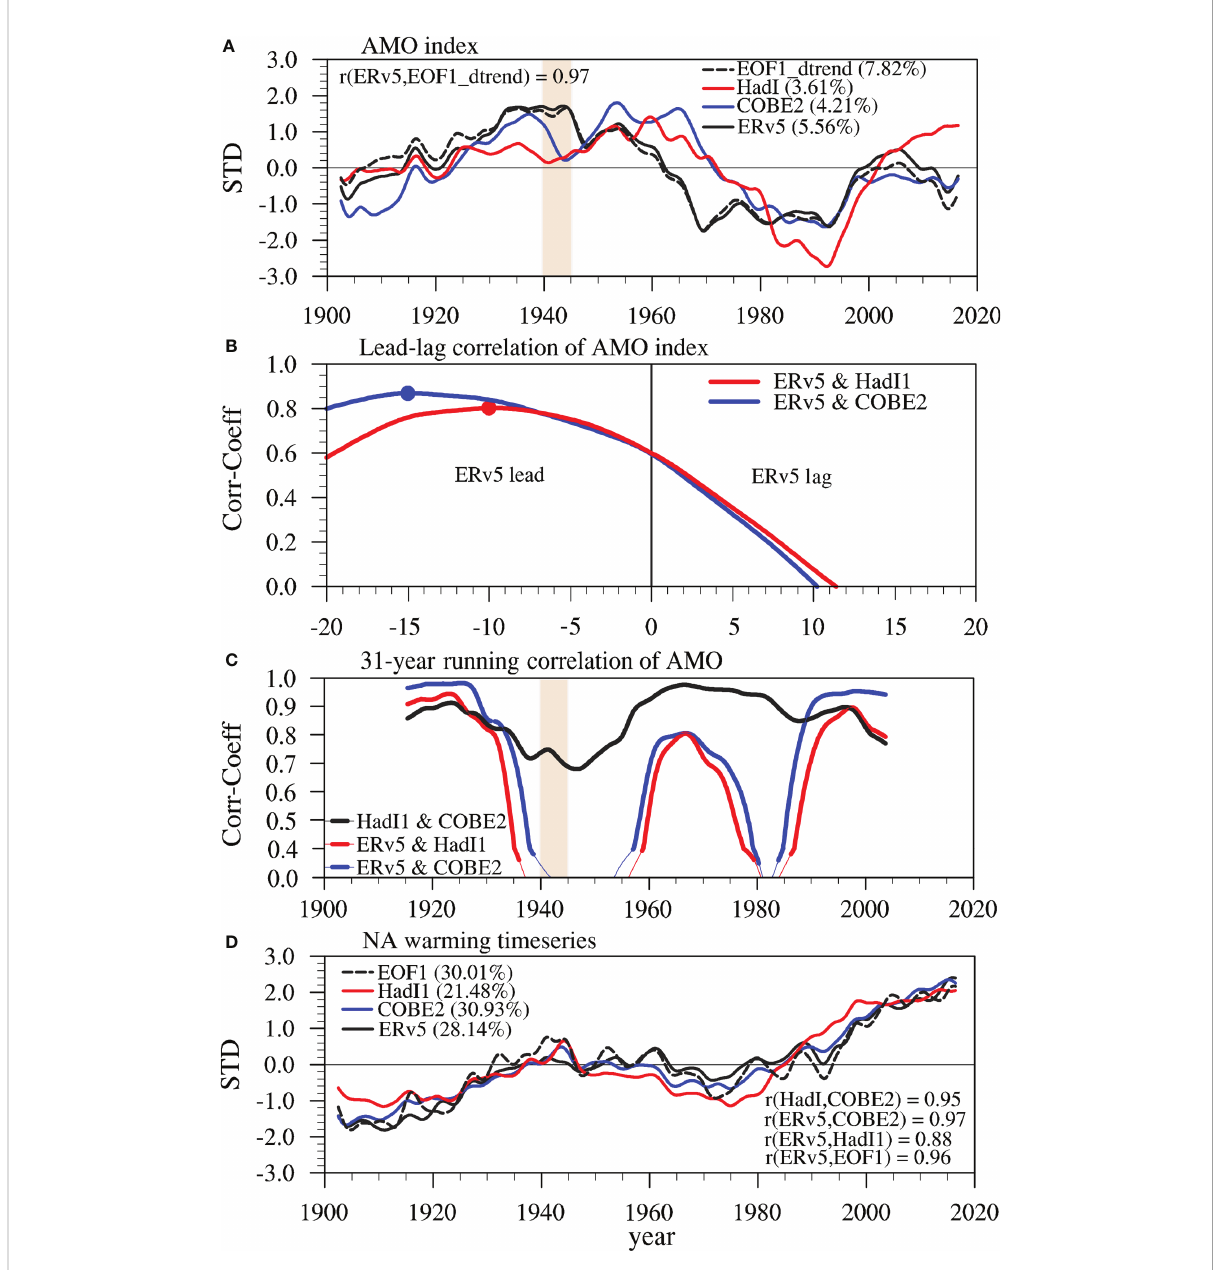
FIGURE 2 (A) AMO index extracted by LFCA from ERv5, COBE2 and HadI1, in which the dashed line is the AMO index extracted by LFCA after removing the fi rst EOF mode and principal component of NASST in ERv5. (B) Lead – lag correlation coef fi cients between the AMO index in ERv5 and those in HadI1 (blue) and COBE2 (red) in 1900 – 2019, in which the dots represent the positions with the maximal correlation coef fi cients. (C) 31-year running correlation of AMO indices among different datasets, in which the thick (thin) lines denote values passing (failing) the 99% signi fi cance level. (D) The warming trend time series in the North Atlantic (the fi rst low-frequency component of LFCA) from ERv5, COBE2 and HadI1, in which the dashed line is the fi rst principal component from EOF in ERv5. The explained variances (%) and TCCs are